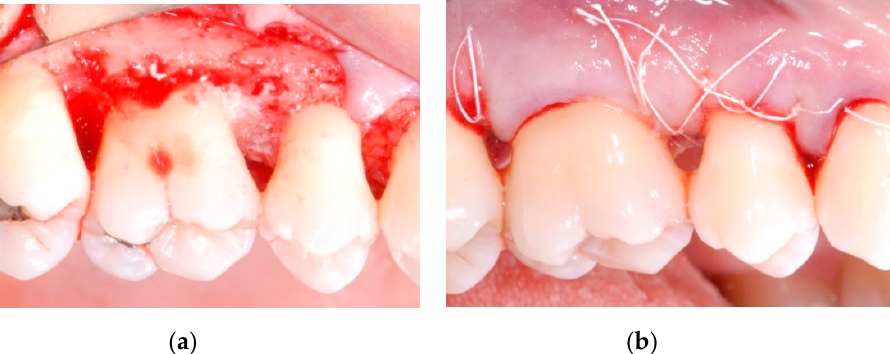
Figure 2. ( a ) After accurate debridement, the intrabony component of the defect was filled by a composite graft consisting in nanohydroxyapatite powder mixed with poly lactic-co-glycolic acid; ( b ) The buccal flap was then slightly released by longitudinal periosteal incision and closed with vertical mattress sutures.